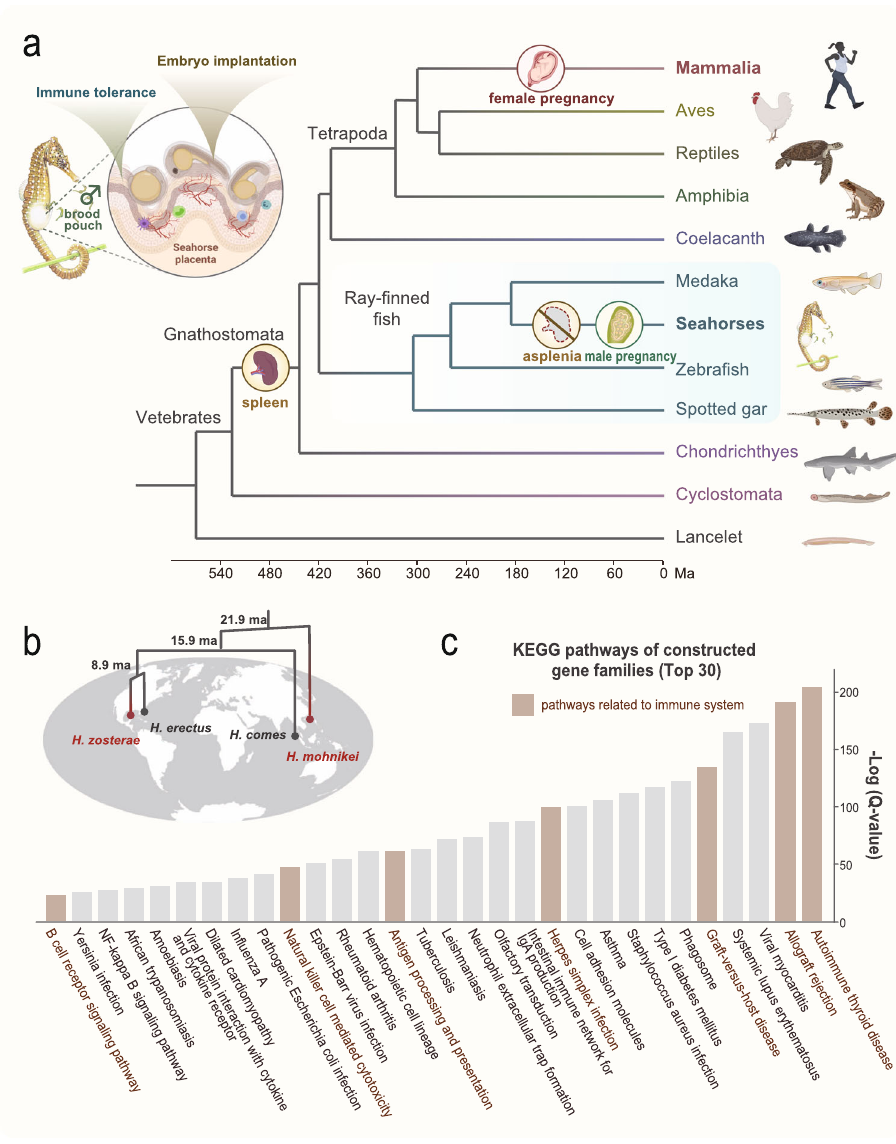
Fig. 1 | Uniquefeaturesofimmunity and reproduction in seahorses. a Aspecies tree showing the evolutionofspecializedmale pregnancyand aspleniatraits inthe seahorse. During pregnancy, embryos implanted in the “ pseudoplacenta ” of male seahorsesarerecognizedbythepaternalimmunesystem. b Fourseahorsespecies, from the major lineages of seahorses were included in the comparative genomic analyses.Newlysequencedspeciesareindicatedinred.Ma,millionyearsago. c The